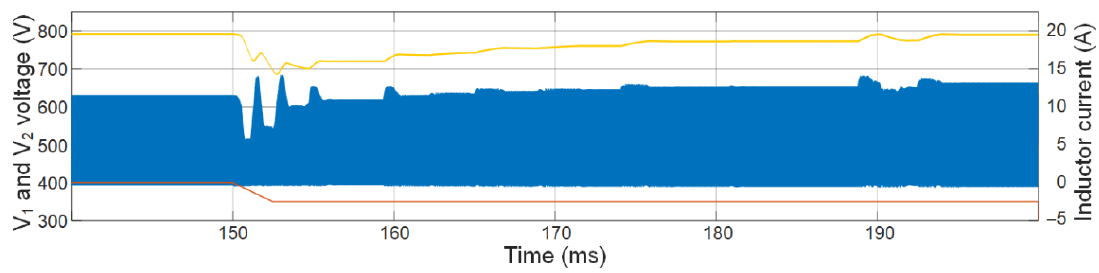
Figure 5. Simulation results of the dynamic behavior of the PI regulator after a step in the input voltage. V 1 changes from 400 V to 350 V in t = 150 ms. V 1 in brown, V 2 in yellow and I L in blue.